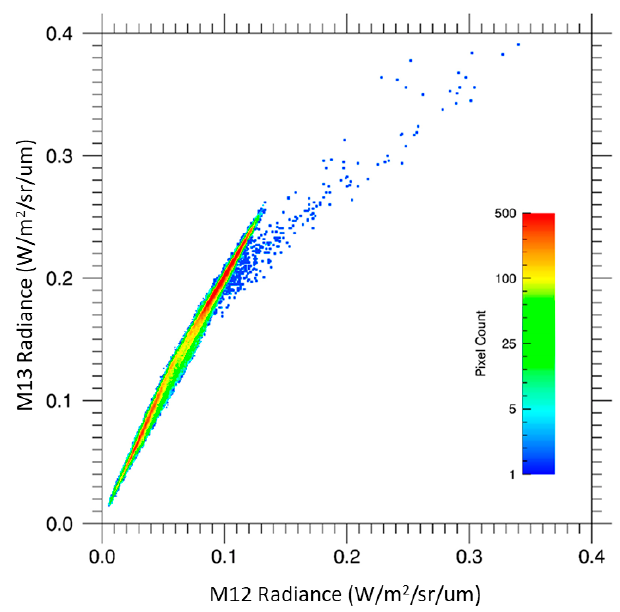
Figure 8. VIIRS has two mid-wave infrared (MWIR) channels that are closely spaced near 4 um. The scattergram shows M12 versus M13 radiances. At night, there is a prominent diagonal data cloud representing the temperature variations in the background. The presence of subpixel IR emitters pulls pixels away from the diagonal. The VNF MWIR detector locates the diagonal, draws an envelope around it, and labels the pixels outside the envelope as detections.